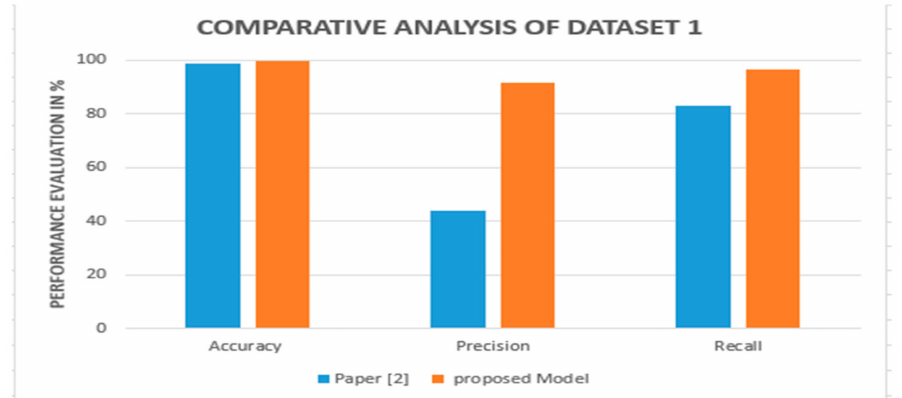
Figure 13. Comparative analysis graph of dataset